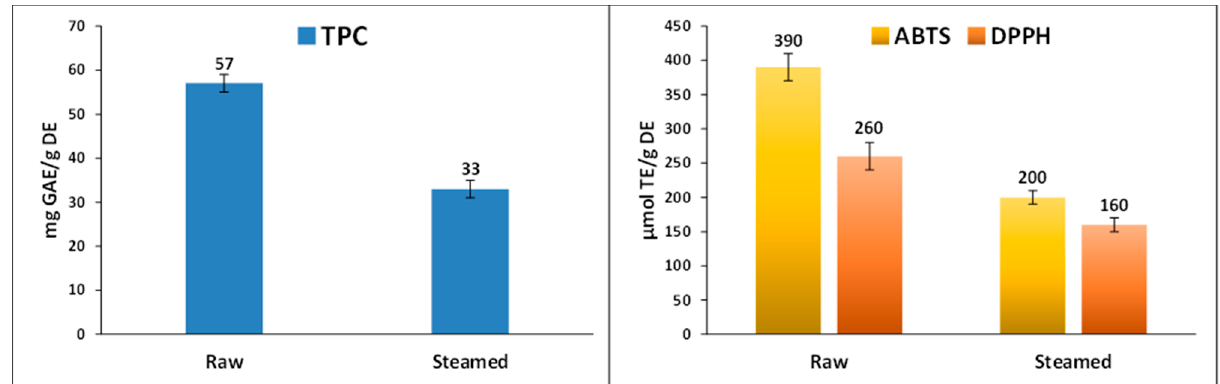
Figure 7. Total phenolic content (TPC) and antioxidant assays (ABTS and DPPH) of raw and steamed Portulaca oleracea aerial parts. Values are given as mean ± standard deviation of three parallel measurements. GAE: Gallic acid equivalent; TE: Trolox equivalent; DE: Dried extract.